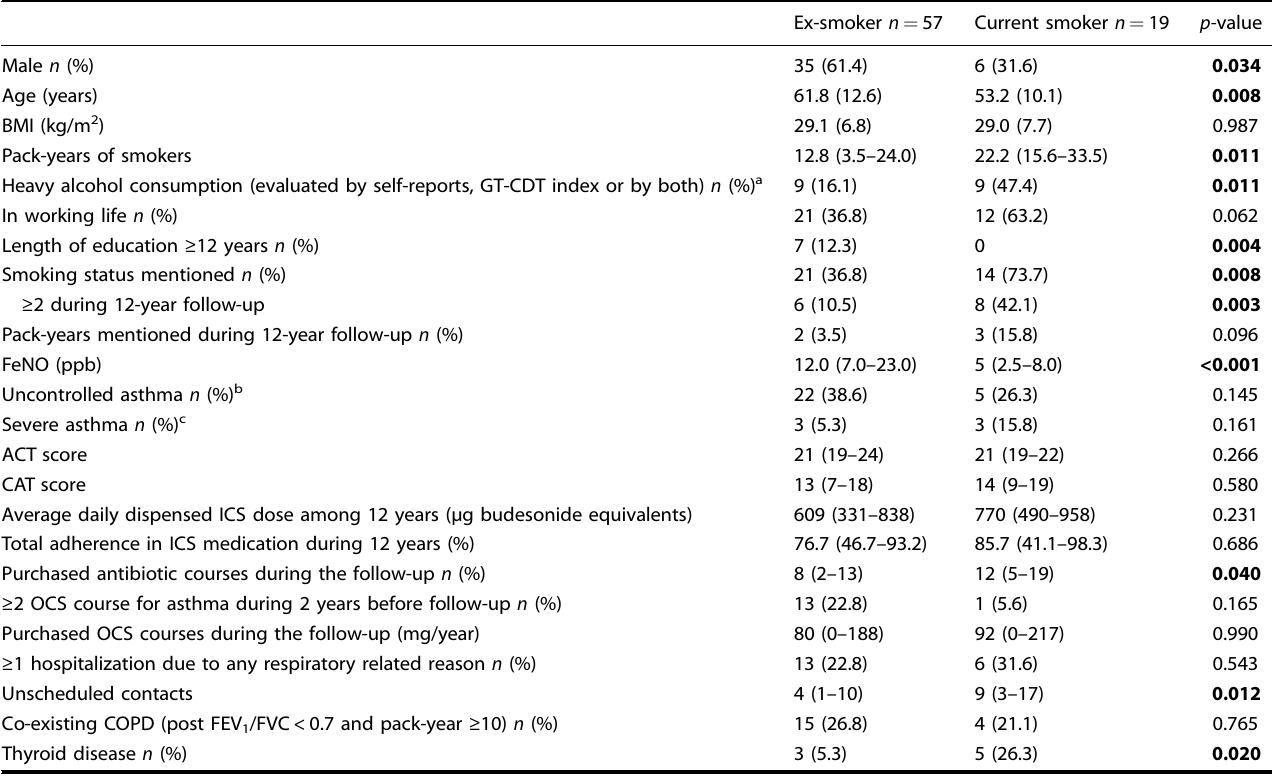
Table 4. Characteristics of ex-smokers and current smokers at the 12-year follow-up